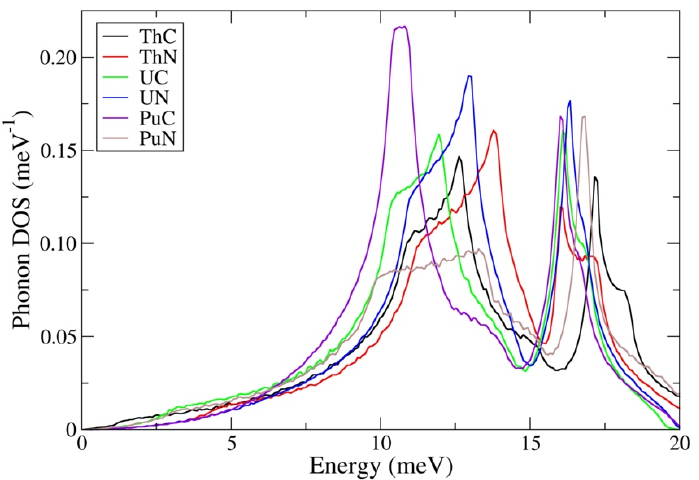
Figure 13. SCAILD phonon density of states (states/meV) at 2000 K for ThC, ThN, UC, UN, PuC, and PuN.